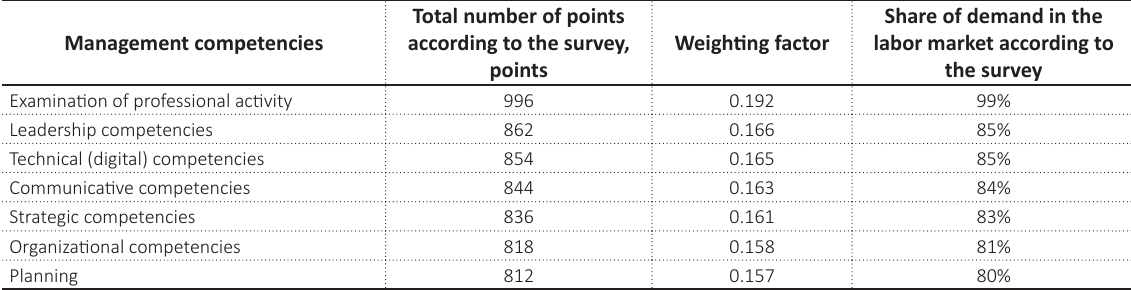
Table A4. Summarized results of an expert survey of Ukrainian employers regarding the demand for managerial competencies